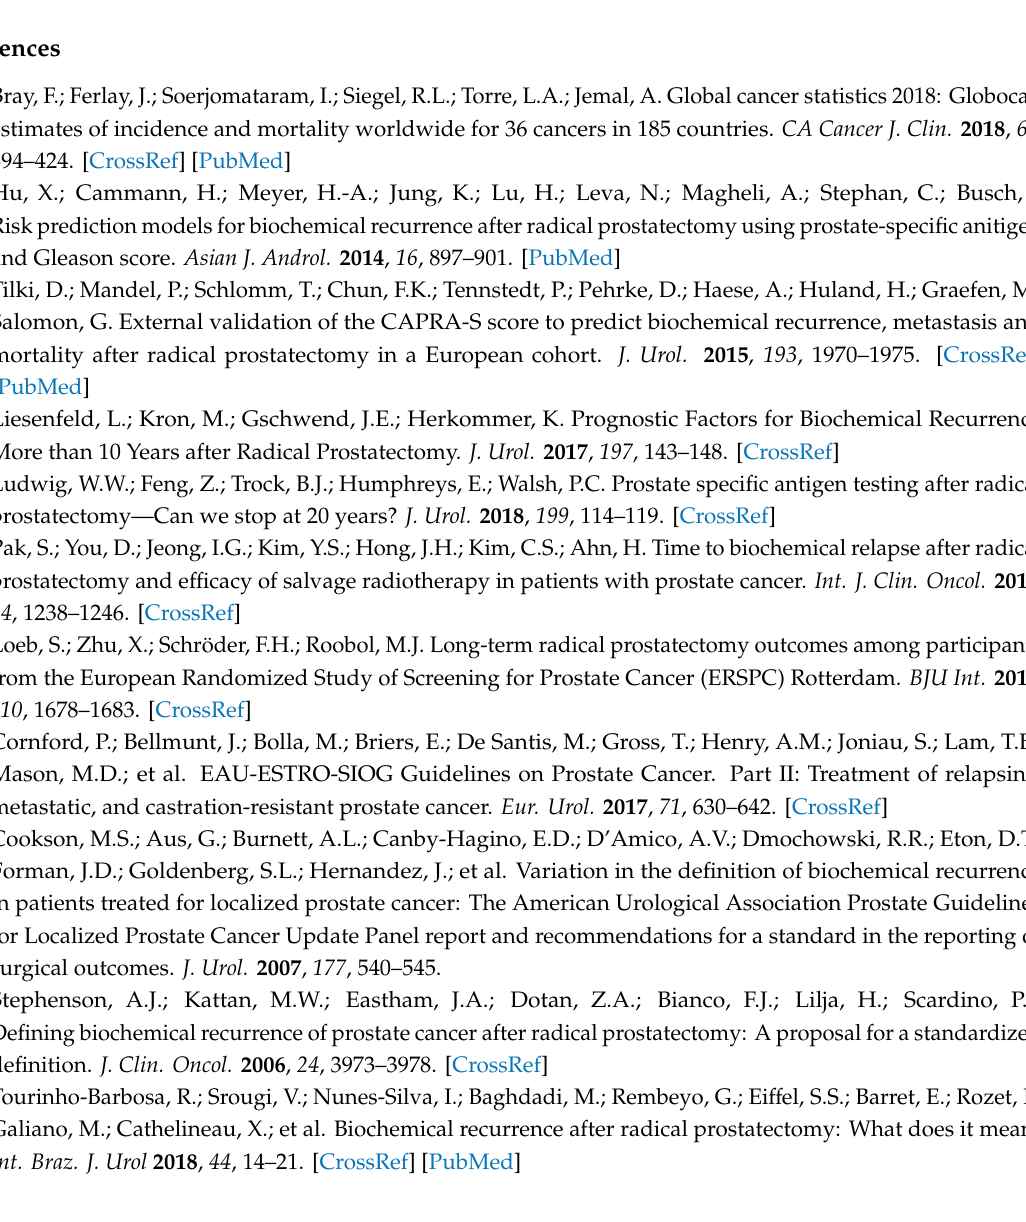
sample splitting approach, Table S8: C-statistics of three predictive BCR models, Figure S1: Expression of the 20 microRNAs, Figure S2: Expression of the 20 microRNAs analyzed in PCa tissue samples categorized according to the pT stages, Figure S3: Expression of the 20 microRNAs analyzed in PCa tissue samples categorized according to the ISUP grades, Figure S4: ROC curve and decision curve analysis of the 5-miR-panel and the 6-miR-panel, Figure S5: Stability of let-7g-5p and miR-103a-3p as suitability criterion for their use as